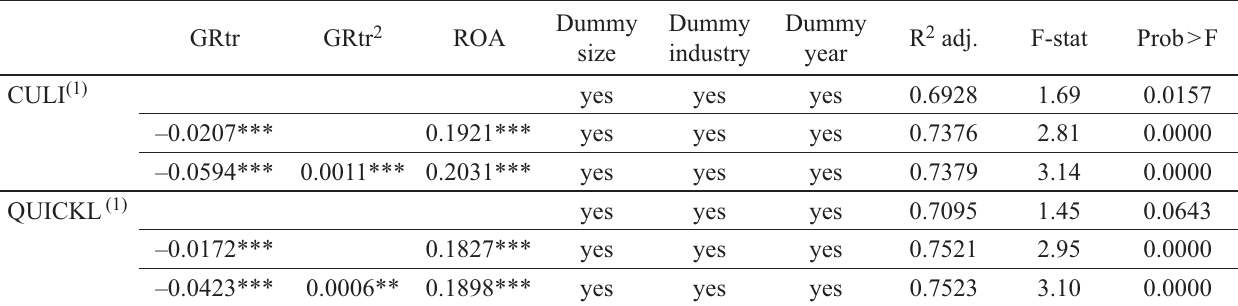
Table 3. Fixed effects models for the dependence of liquidity on the growth rate and control variables